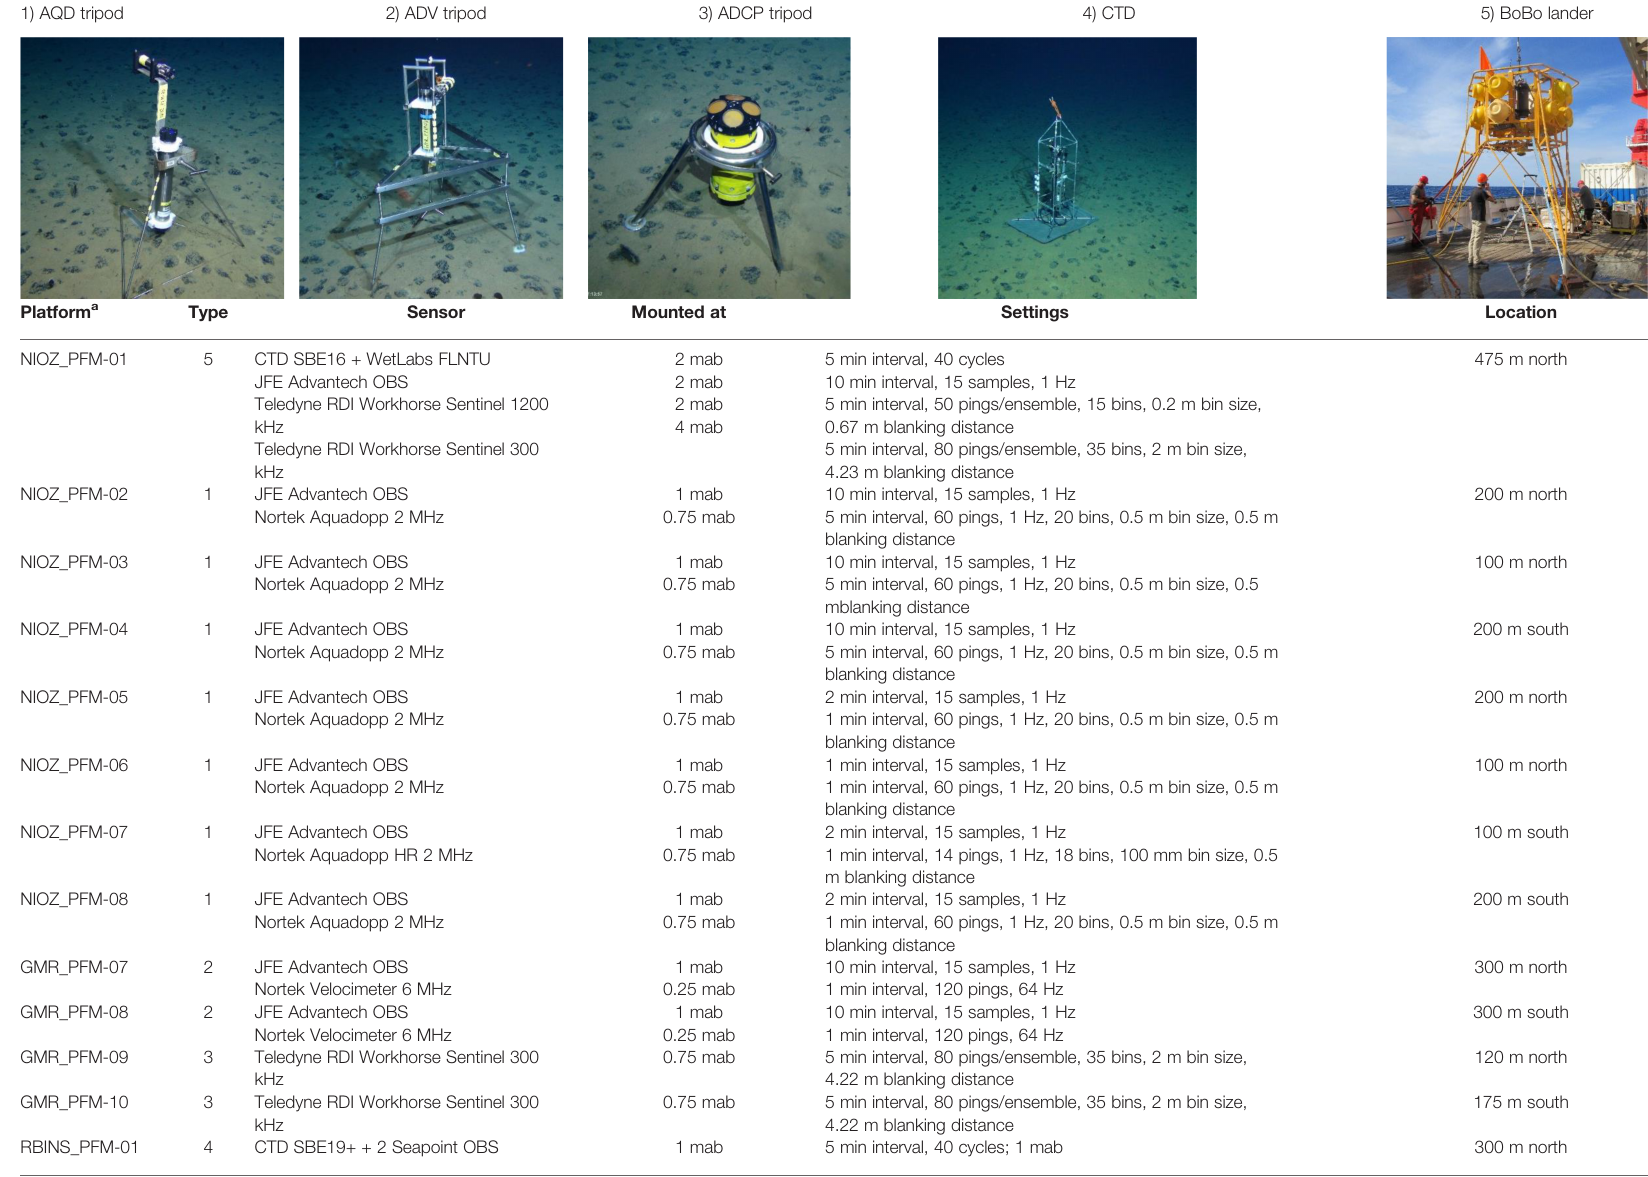
TABLE 2 | Speci fi cations of all sensors used in the monitoring array around the dredge experiment